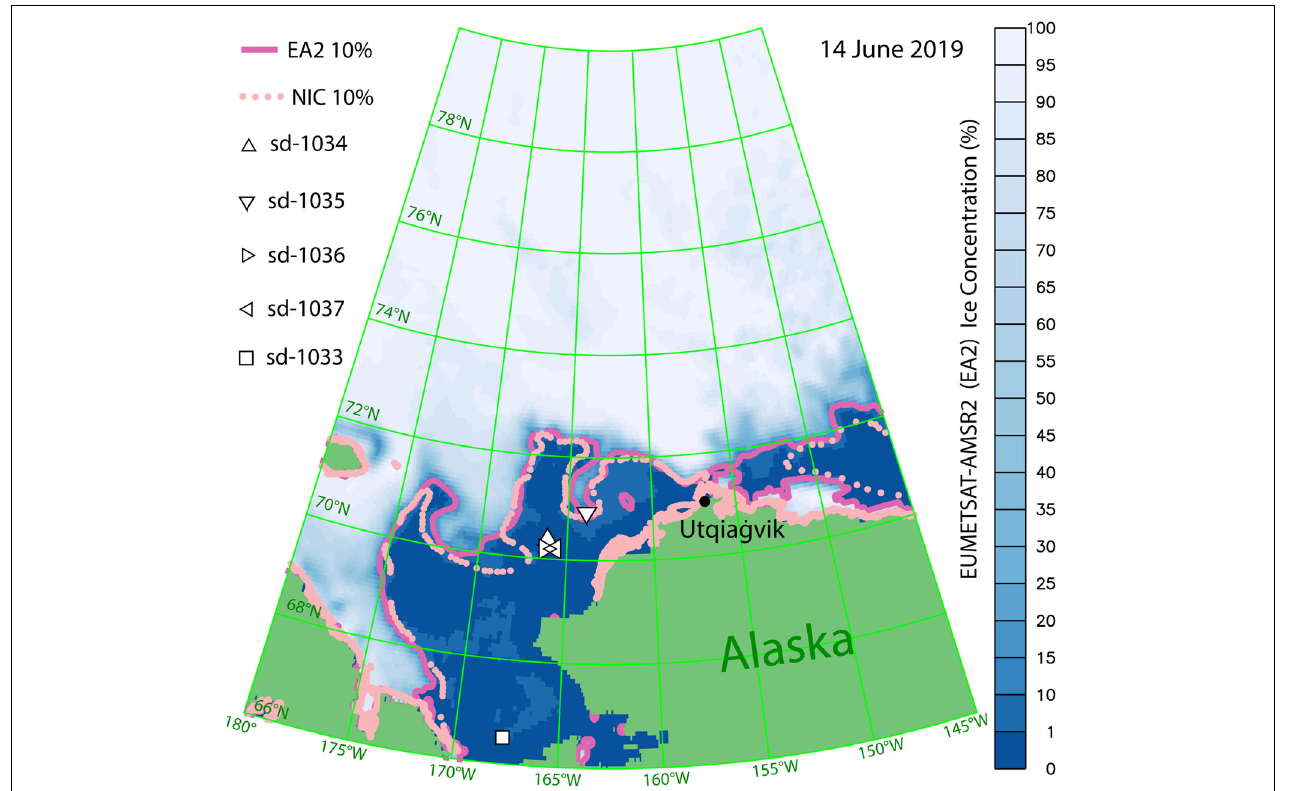
FIGURE 2 | The Eumetsat-AMSR2 (EA2) estimate of sea-ice concentration (blue-white hues) and 10% ice contour (solid purple curve) along with the NIC ‘ice edge’ 10% contour (pink dotted curve) and locations of saildrones sd-1033 (square), sd-1034, sd-1035, sd-1036, and sd-1037 (triangles) on 14 June 2019, the date of the mission’s first ice encounter